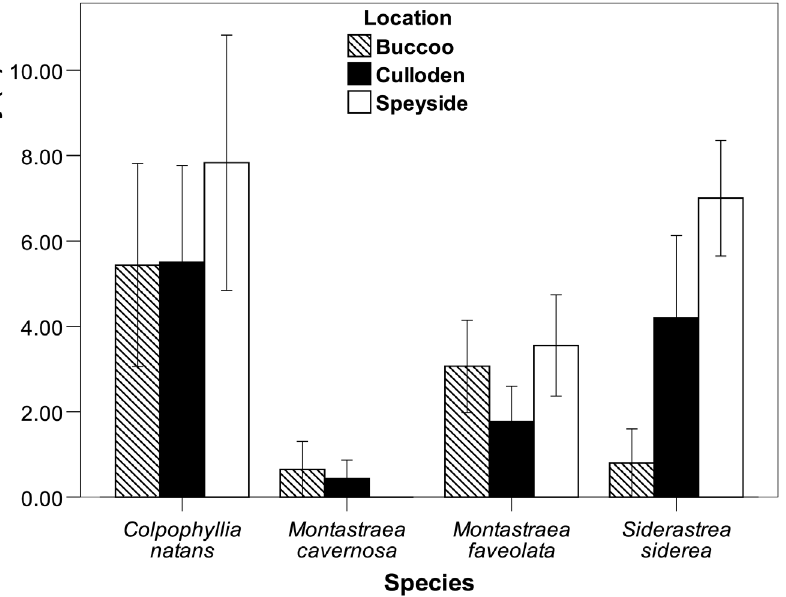
Figure 6. Percent bleaching mortality of four framework building taxa at Buccoo, Culloden and Speyside following the onset of the bleaching event (October 2010). Bars represent standard error.